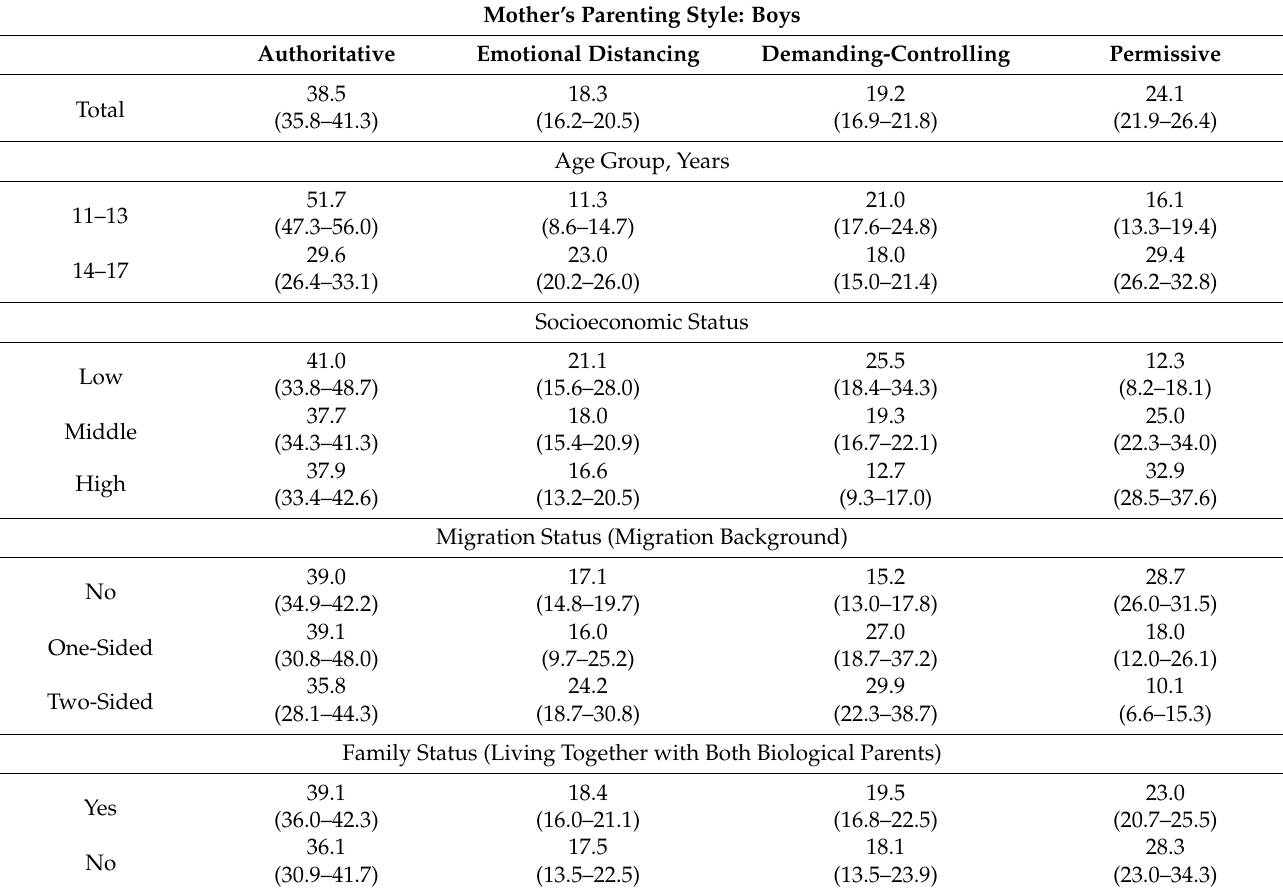
Table 2. Parenting style of mothers stratified by children’s age and gender, socioeconomic status, migration status, and family status (weighted prevalence in % and 95% confidence